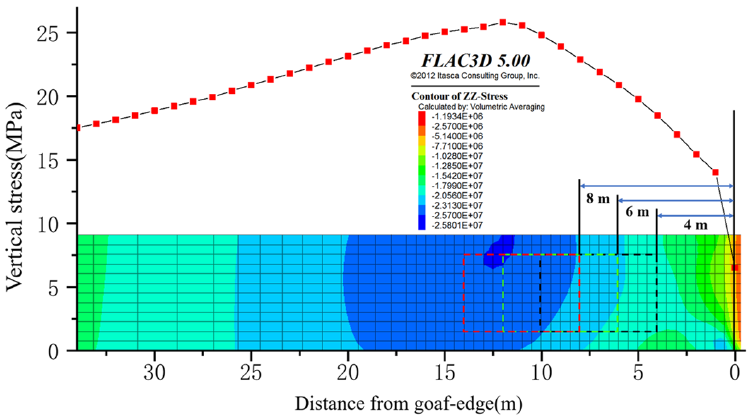
Figure 10. Vertical stress distribution in the yield pillar; the position of roadway is shown in dotted